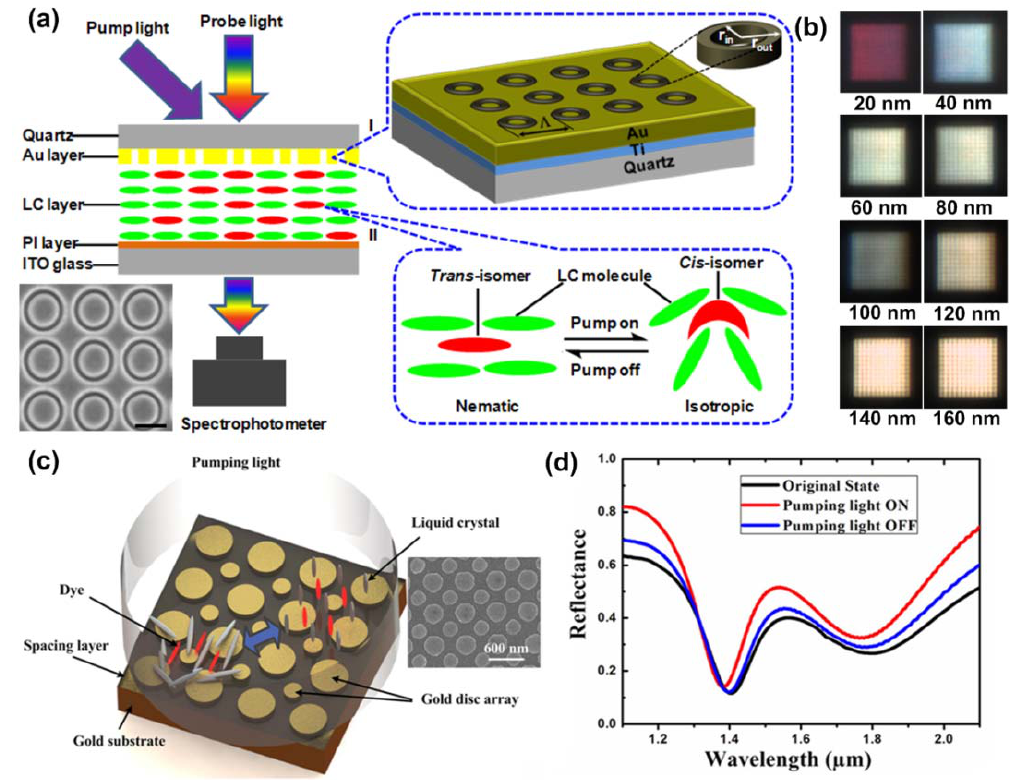
Figure 8. ( a ) Light driven plasmonic color filter tuned by liquid crystals. The nanostructure used is a new type AAA that can generate different colors by changing the sizes and periods of AAA. One example of AAA is given in the inset; ( b ) different colors generated using plasmonic color filters. By pumping the liquid crystal mixtures to realign the liquid crystal molecule orientation, intensity modulation on the ultra-small color filter can be achieved and demonstrated in the reported work.; ( c ) one representative case of reconfigurable plasmonic absorber using liquid crystal. The small and big nanodisk arrays in the inset are designed to produce two absorption maximums to improve the performance of the plasmonic absorbers and ( d ) light sensitive liquid crystal mixture is used to tune the absorption dips in real time. Experimental results confirm a tuning range around 25 nm in the near infrared range. Figure 8a,b is adapted from reference [39] while Figure 8c,d is adapted from reference